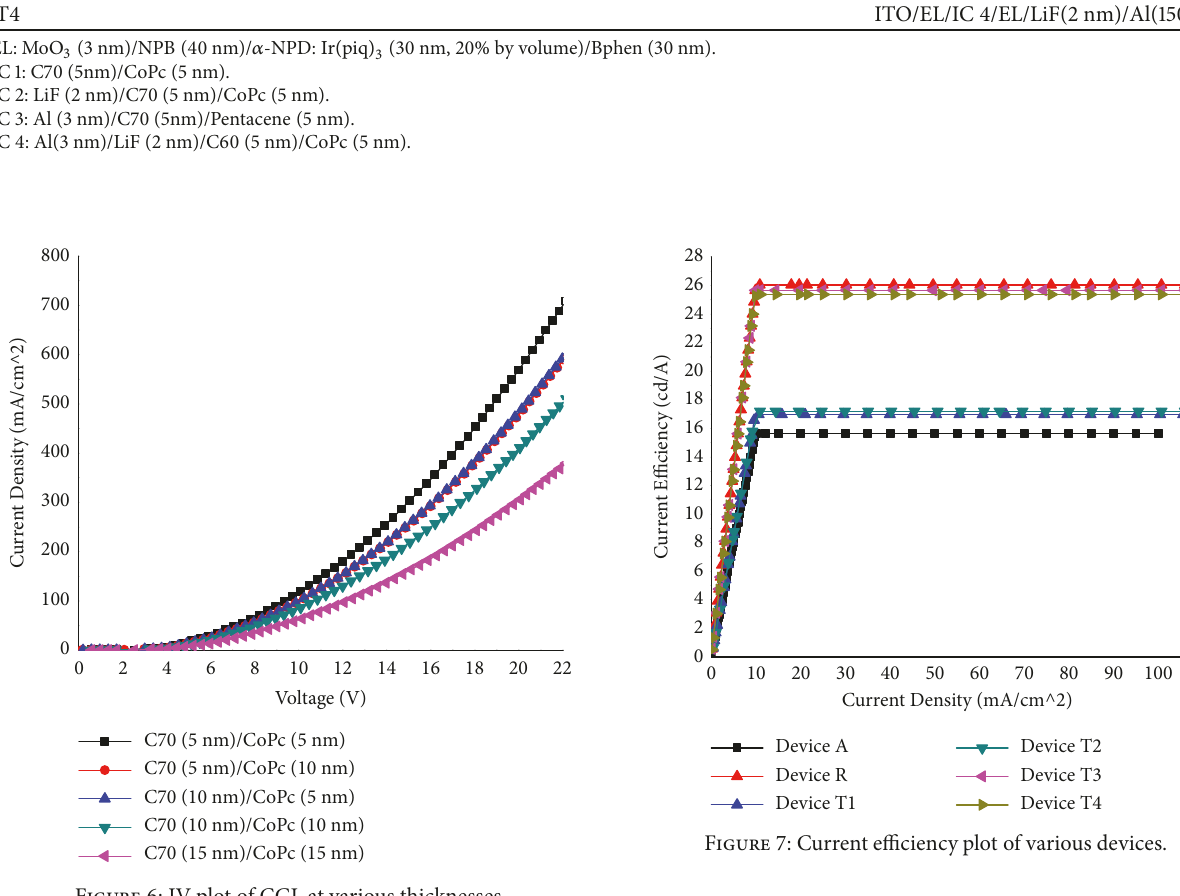
Figure 6: JV plot of CGL at various thicknesses.